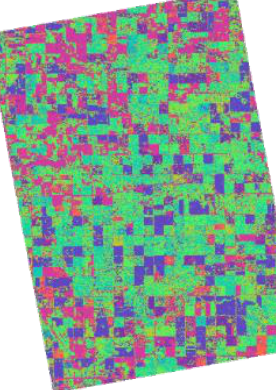
Figure 6 . H/ 𝛼 /Wishart classified band